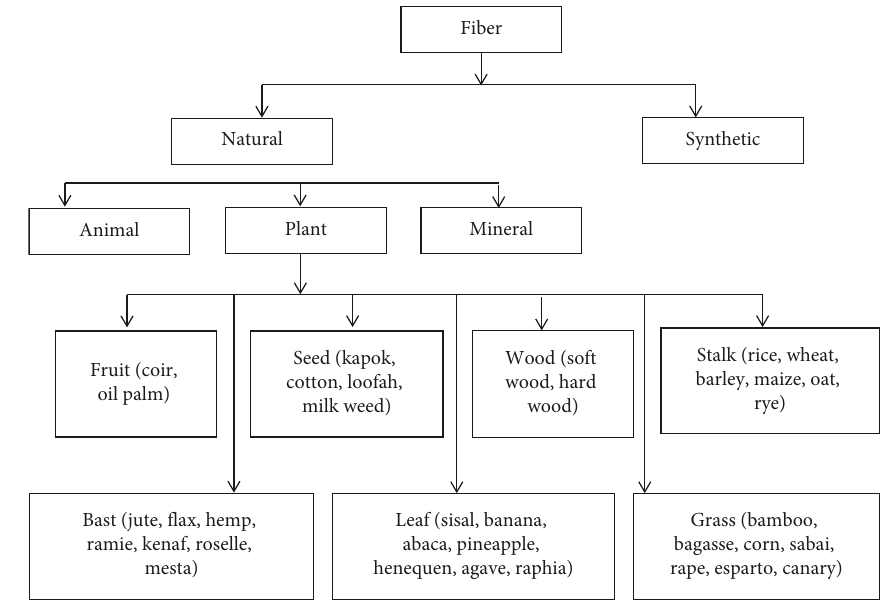
Figure 2: Classification and subclassification of natural fibers [63]. Table 6: Availability of natural fibers [66].